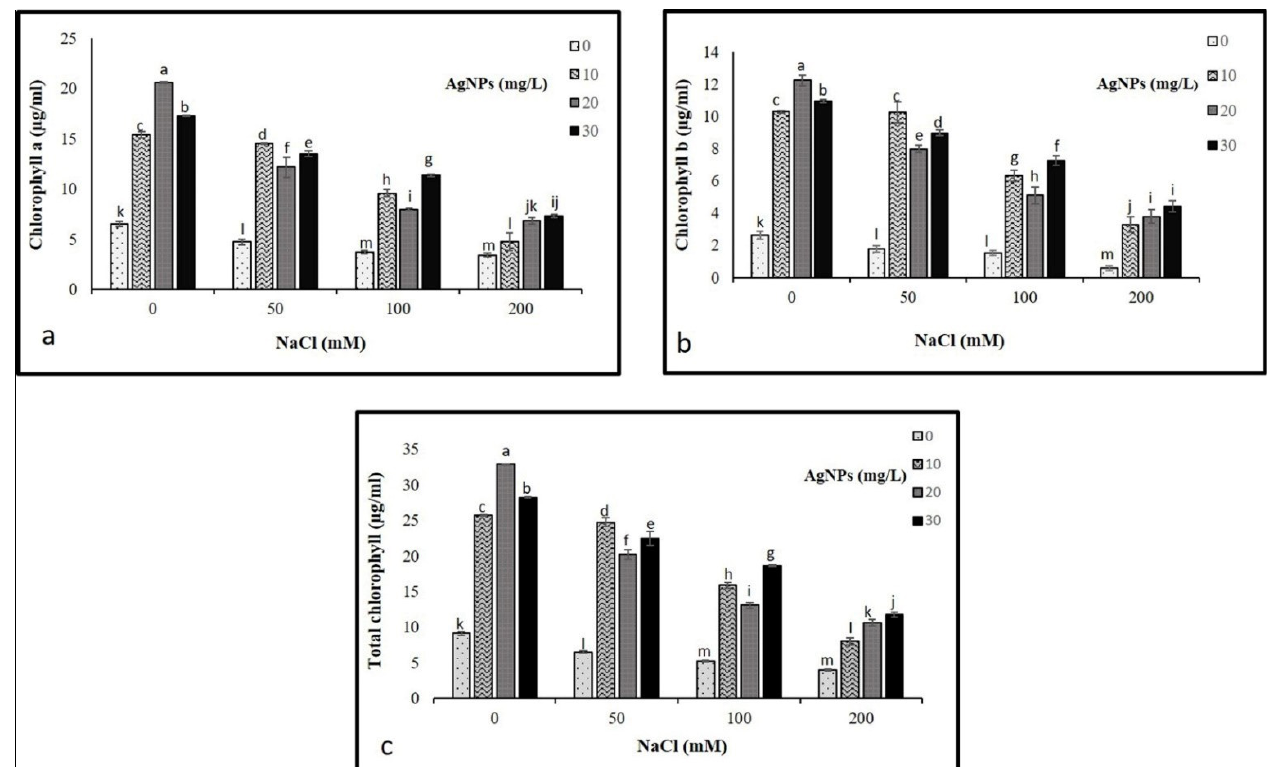
Figure 4. Photosynthetic pigments ( a ) Ch a, ( b ) Ch b, and ( c ) total chlorophyll in Maerua oblongifolia leaves under salt stress and application of silver nanoparticles. Means ± SD for each treatment followed by the same letters are not significantly different according to the Duncan’s test ( p ≤ 0.05).